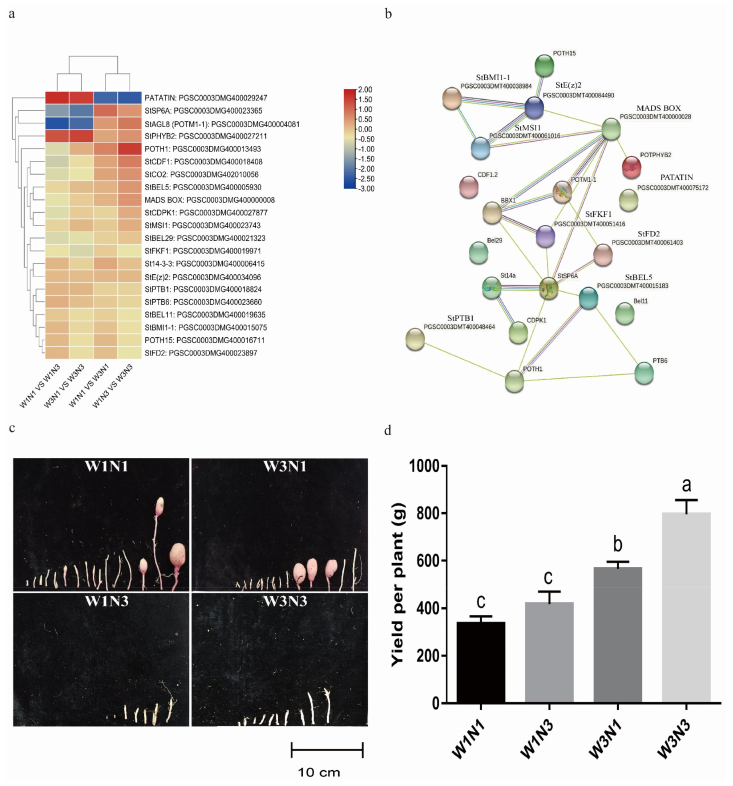
Figure 4. Potato tuber development in response to variations in water and nitrogen levels ( a ) Heatmap showing expression of tuber development-related genes in response to changes in water and nitrogen levels. ( b ) Protein interaction network. In the network, the circular node with a specific number represents the protein, and the interconnecting lines represent the source by which protein interactions are derived. Sources of protein interaction were represented with black, pink, green, and blue lines that represent co-expression, experimental data, text mining, and homology, respectively. ( c ) Tuber development during tuber expansion in each treatment group. ( d ) Yield of each treatment group. Values on bar are mean ± standard error ( n = 9). Different letters indicate significant differences ( p <